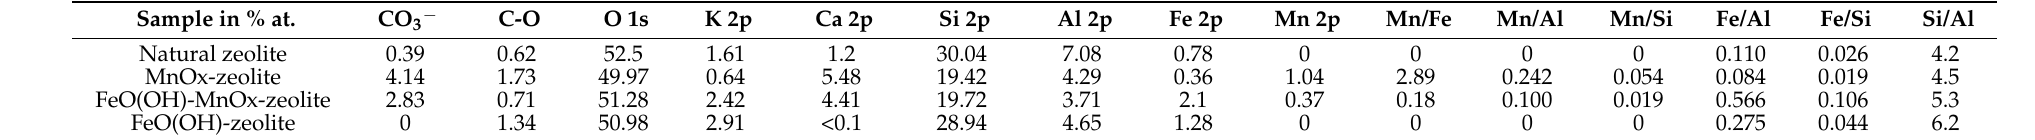
Table 2. Surface composition (% at.) using the XPS method of all the samples studied of grain-size 0.2–0.5 mm. Sample in %